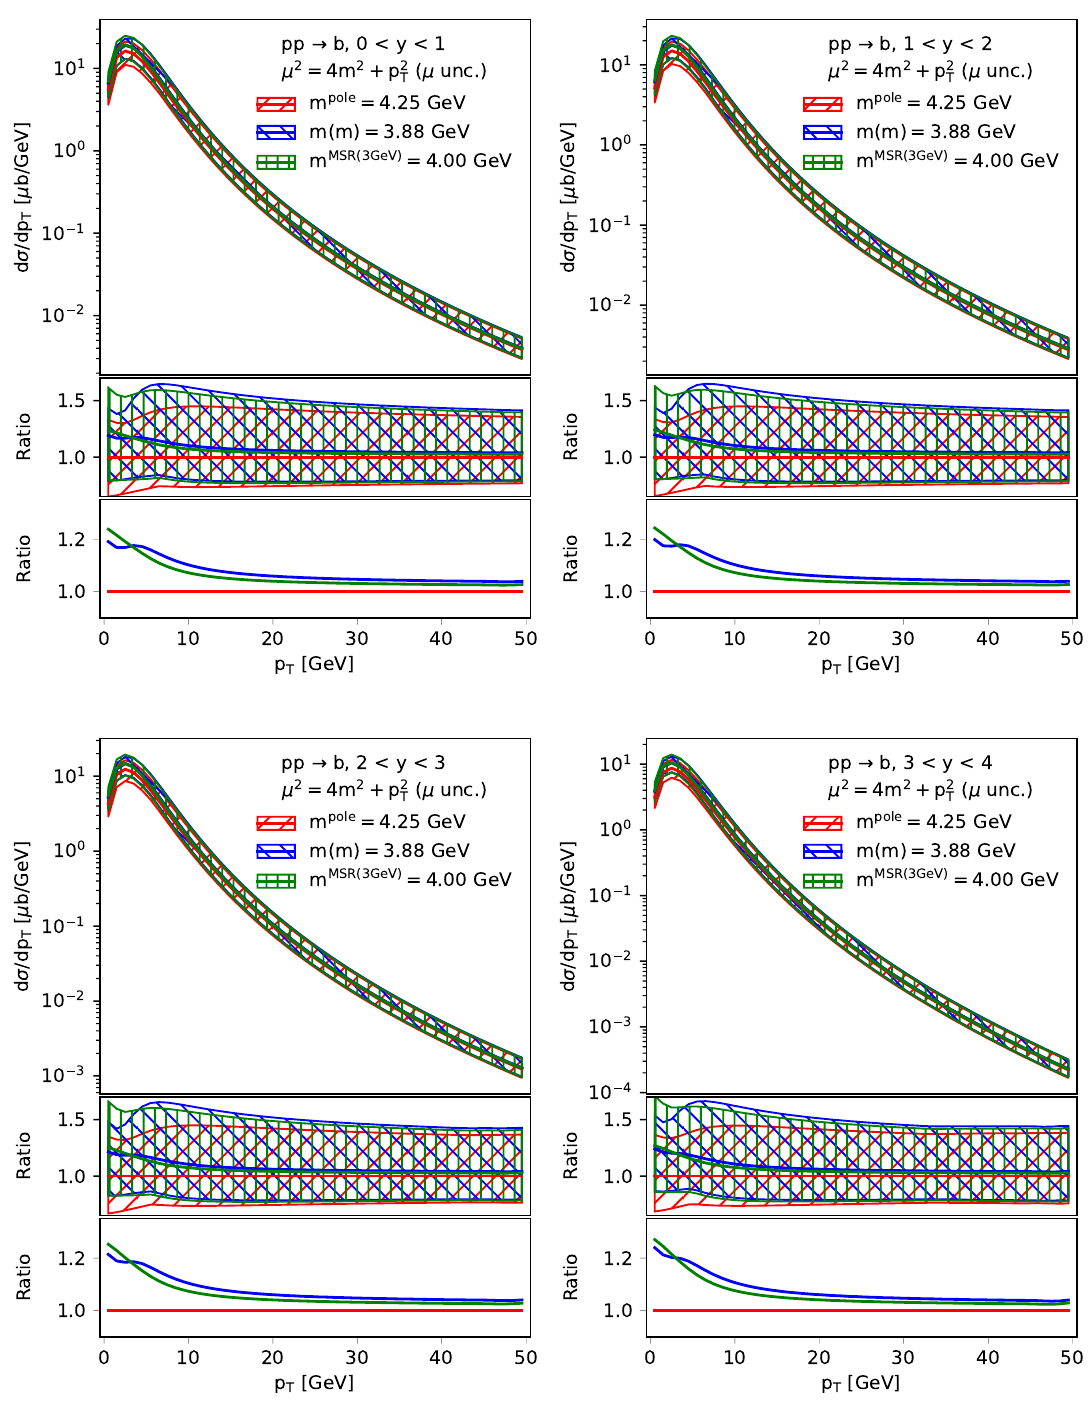
Figure 5 . Same as figure 4, but for the bottom-mass value m b ( m b ) = 3.88 GeV (converted to m MSR (3 GeV) = 4.00 GeV and m pole = 4.25 GeV), as extracted in the ABMP16 NLO b b